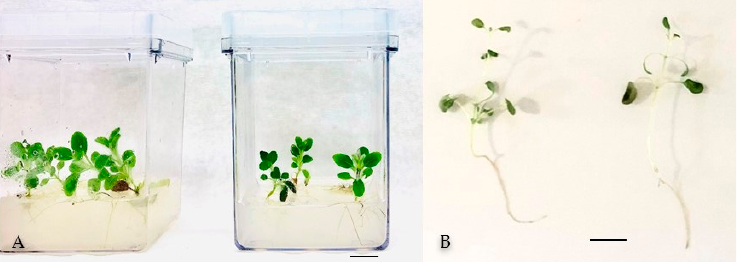
Figure 3. Germination time course curves of Sideritis raeseri subsp. attica seeds affected by temperature. Four Petri dishes (15 seeds/treatment) were used.